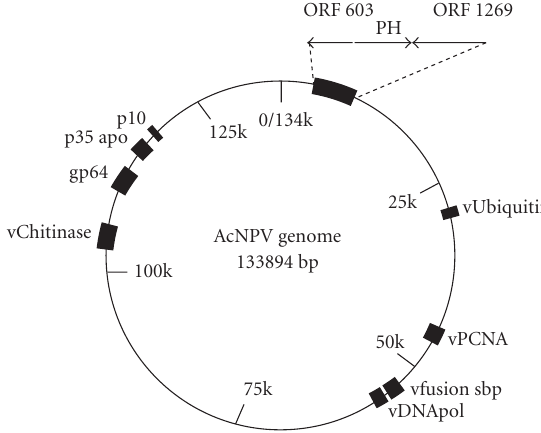
Figure 2. Genomic map of Bv (AcNPV) genome. Some signifi- cant open reading frames are indicated. Detail is the polyhedrin (PH) cloning sites for